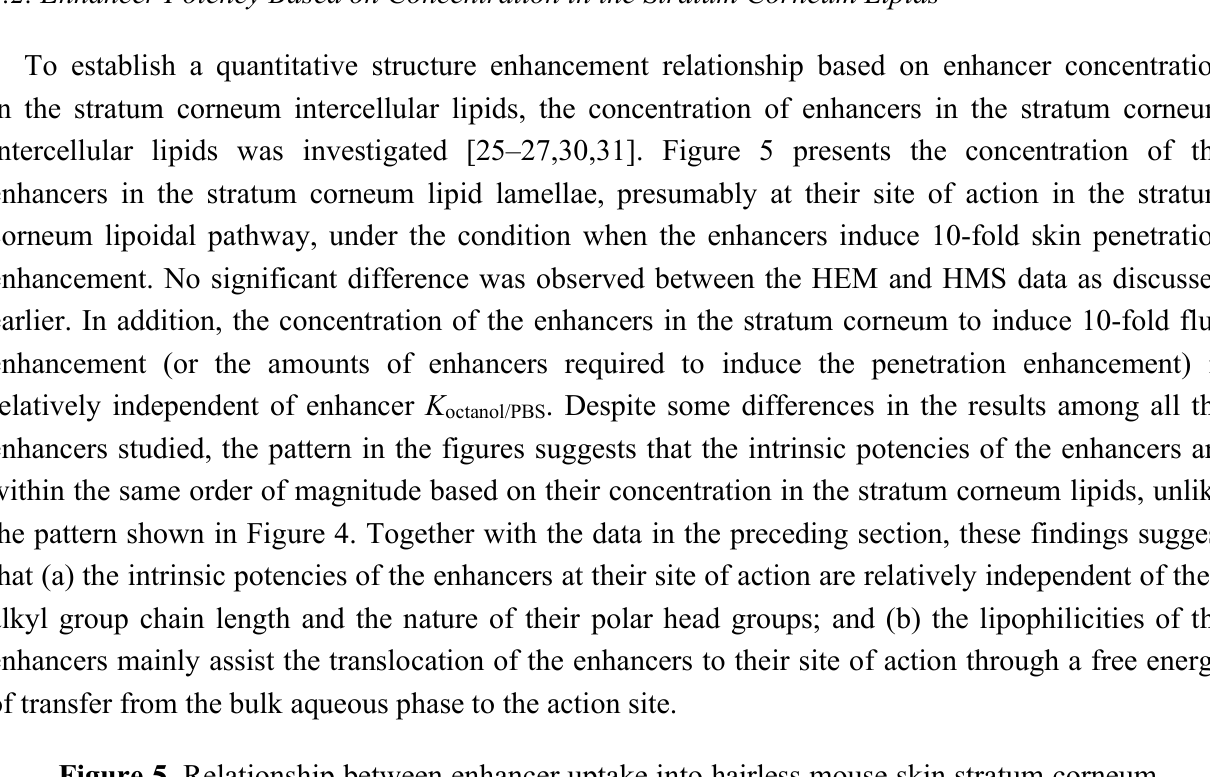
Figure 5. Relationship between enhancer uptake into hairless mouse skin stratum corneum (HMS SC) and human epidermal membrane stratum corneum (HEM SC) (  mol/mg intercellular SC lipid) under the aqueous enhancer concentration to induce 10-fold penetration enhancement and enhancer K (octanol/PBS partition coefficient). The octanol/PBS data are taken from previous hairless mouse skin (HMS) and human epidermal membrane (HEM) studies [25–27,30,31]. PBS = phosphate buffered